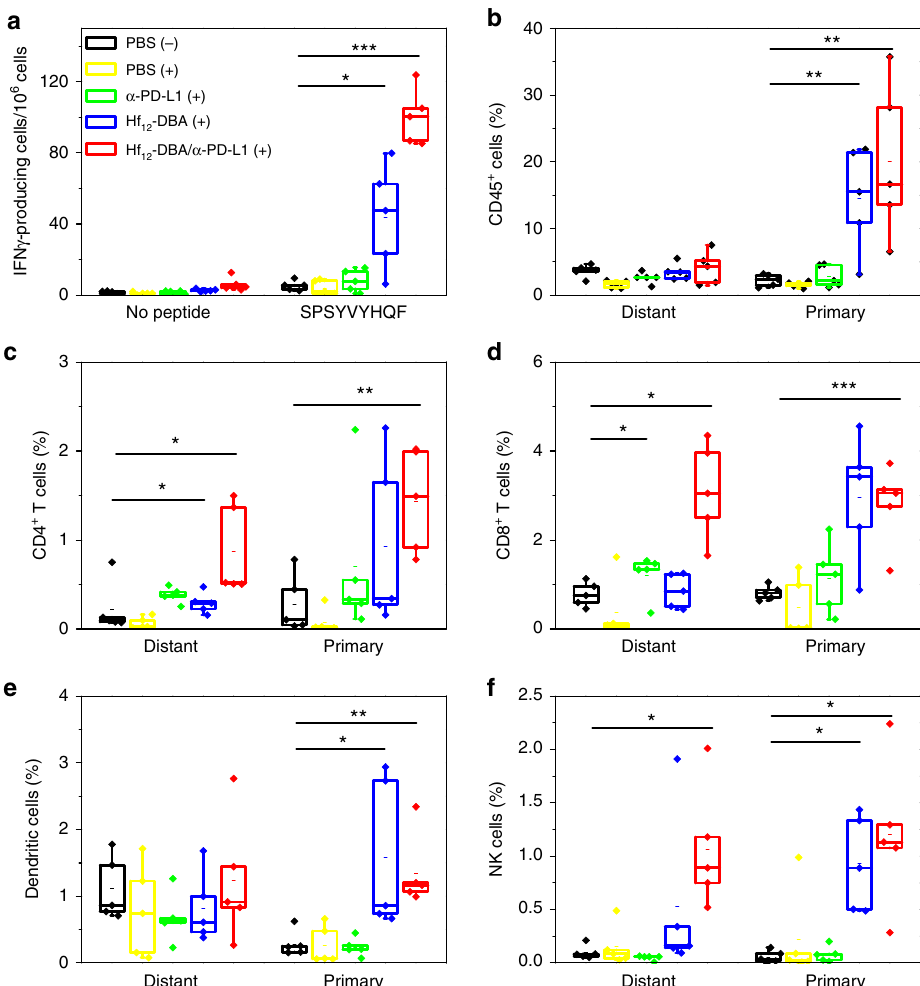
Fig. 6 Tumor-speci fi c immune responses. Bilateral tumor models of CT26 were established and treated as described in Fig. 4. Ten days after the fi rst treatment, the splenocytes were harvested and stimulated with 10 μ g/mL SPSYVYHQF peptide for 42 h. ELISPOT assay was performed to detect IFN- γ producing T cells ( a ). The primary (right) and distant (left) tumors were collected for fl ow cytometry analysis and the percentage of tumor-in fi ltrating CD45 + cells ( b ), CD4 + T cells ( c ), CD8 + T cells ( d ), dendritic cells ( e ), and NK cells ( f ) with respect to the total tumor of cells treated with PBS dark control, PBS, anti-PD-L1 antibody, Hf 12 -DBA, or Hf 12 -DBA plus anti-PD-L1 antibody with X-ray irradiation. n = 5. * P < 0.05 from control, ** P < 0.01 from control, and *** P < 0.001 from control by t test. Central lines, bounds of box and whiskers represent mean values, 25% to 75% of the range of data and 1.5- fold of interquartile range away from outliers,